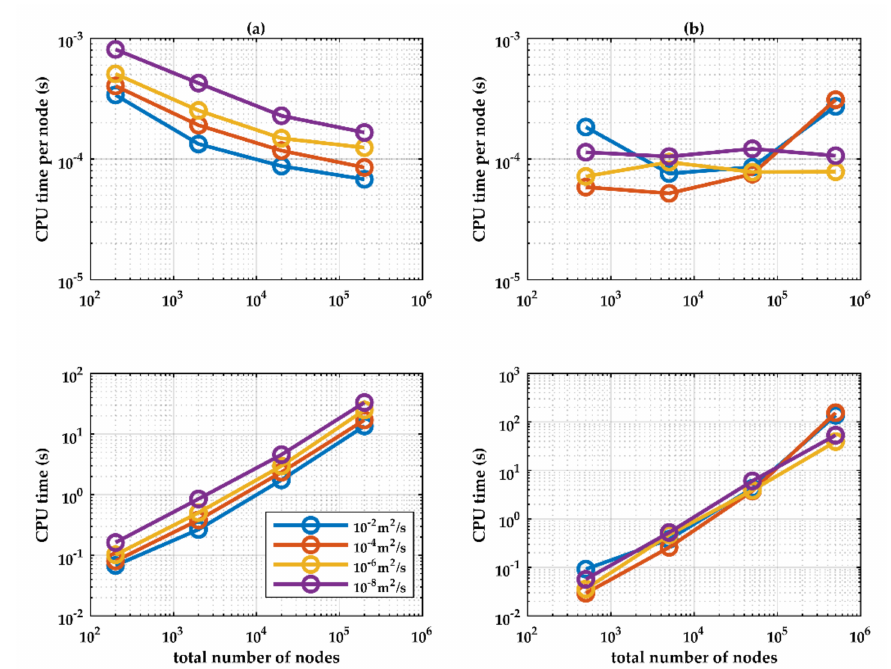
Figure 12. CPU time evolution with the number of nodes when ( a ) the spatial step is kept constant and when ( b ) the domain span is